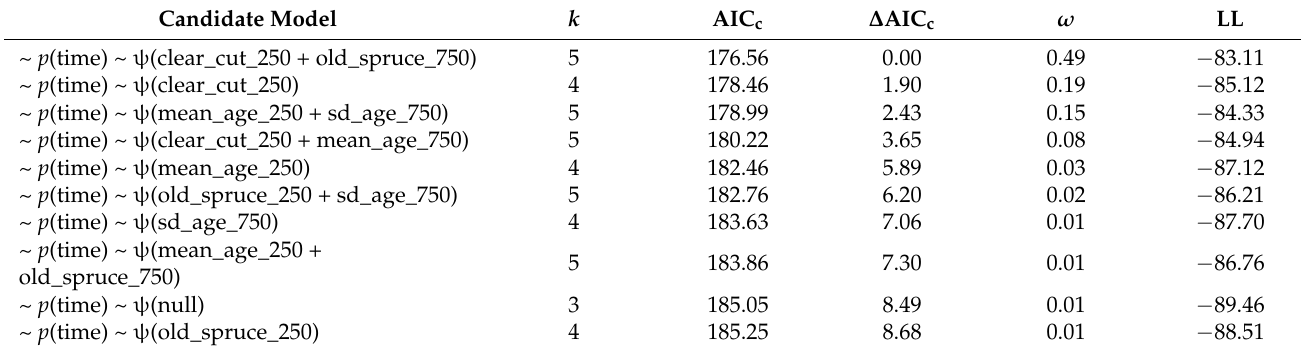
Table 2. Candidates models, number of parameters ( k ), second-order Akaike’s information criterion (AICc), ∆ AICc, Akaike weights ( ω ), log-likelihood (LL) of the candidate models assessing occupancy ( ψ ) and detection probability ( p ) of American Three-toed Woodpecker in a managed boreal forest in eastern Canada. Candidate Model k AIC